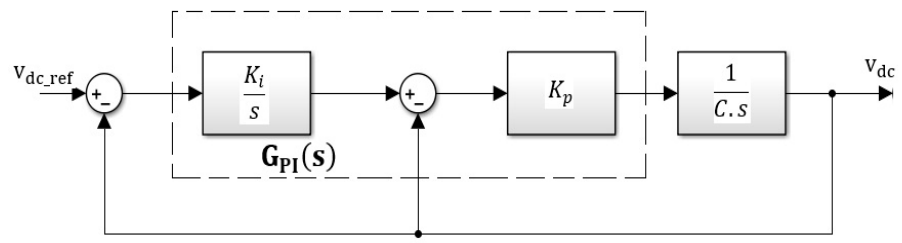
Figure 6. DC voltage control closed-loop.